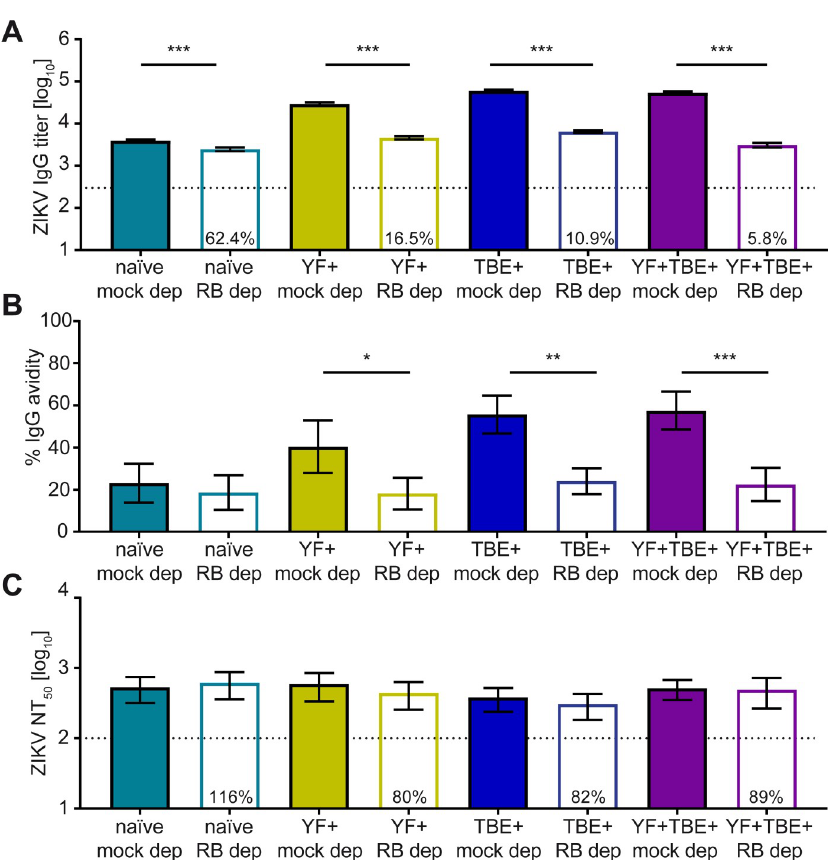
Fig 6. Effect of depletion of cross-reactive antibodies from serum pools with Rio Bravo virus E on Zika virus antibody titers. (A) Zika virus IgG ELISA titers, (B) relative avidity of Zika virus-specific IgG, and (C) Zika virus NT 50 titers. Colored columns: mock depletion, empty columns: RB depletion. Percentages in the empty columns of (A) and (C) indicate residual ELISA reactivity and neutralizing activity after depletion, respectively. Data are shown as mean values +/- SEM from three independent experiments. The dotted line indicates the cut-off of the assay. Significant differences between mock depletion and RB depletion are indicated by asterisks (2-way ANOVA with linear contrasts); � , p < 0.05; �� , p < 0.01; ��� , p < 0.001. ZIKV, Zika virus; mock dep, IgM and mock-depleted serum pool; RB dep, IgM and Rio Bravo virus E-depleted serum pool.